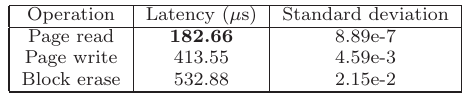
Table 1: Traced driver level flash